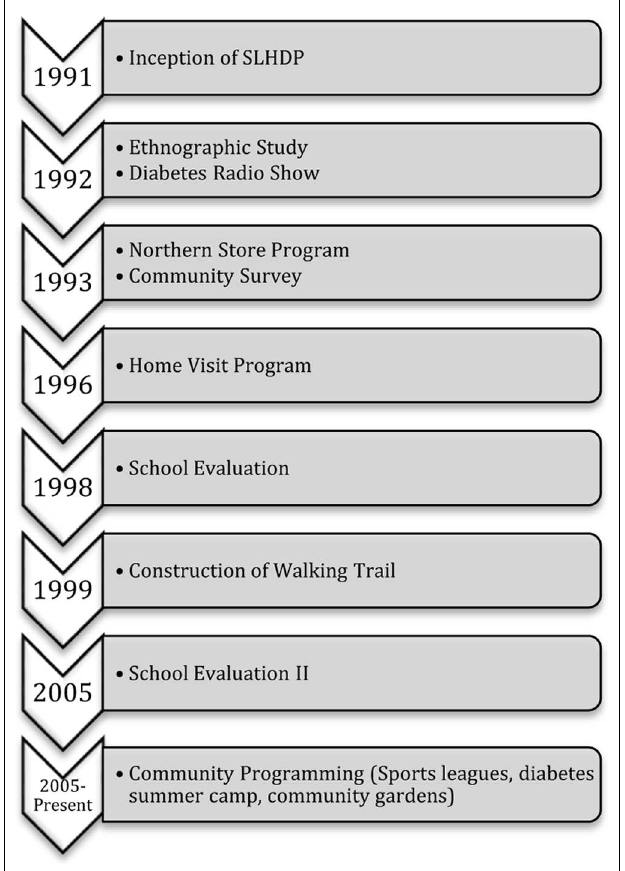
FIGURE 1 | Progression of the SLHDP from 1991 to present